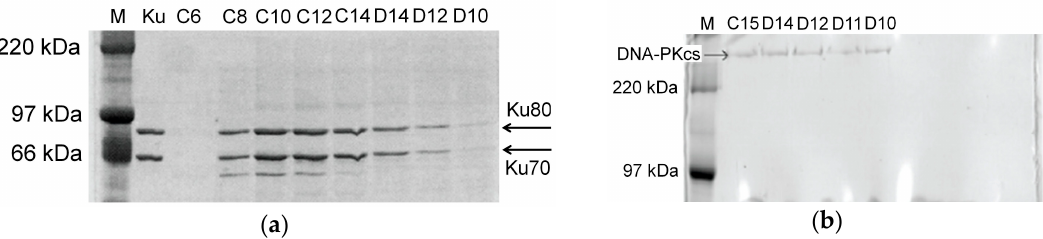
Figure 1. Examples of end results of different protein purification techniques. ( a ) SDS-PAGE analysis of Ku fractions obtained after the third column chromatography (heparin-agarose) step. M—marker, Ku—Ku control, C8 – D10—chromatography fractions; ( b ) SDS-PAGE analysis of the DNA-PKcs fractions after single step Hi-Trap affinity chromatography. M—marker, C15 – D10—chromatography fractions. Coomassie staining was used in both cases. See text for details. Reproduced from [28].